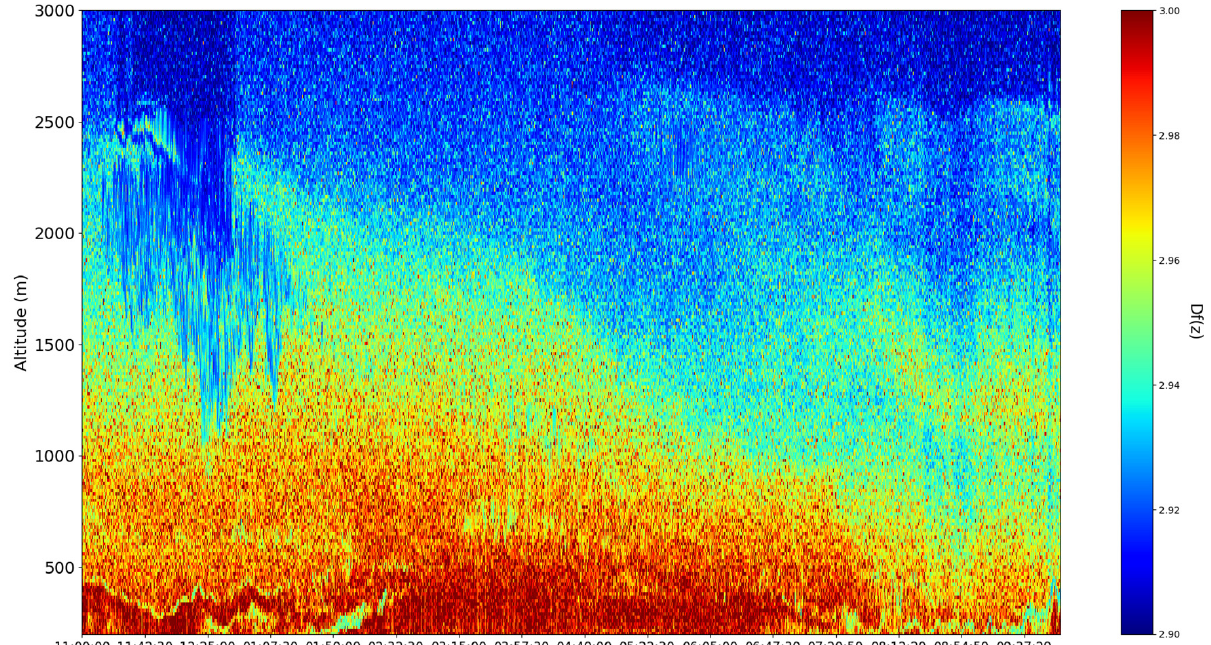
Figure 19. D (cid:2890) timeseries, λ = 1064 nm , Gala ț i, Romania, 22 December 2021.